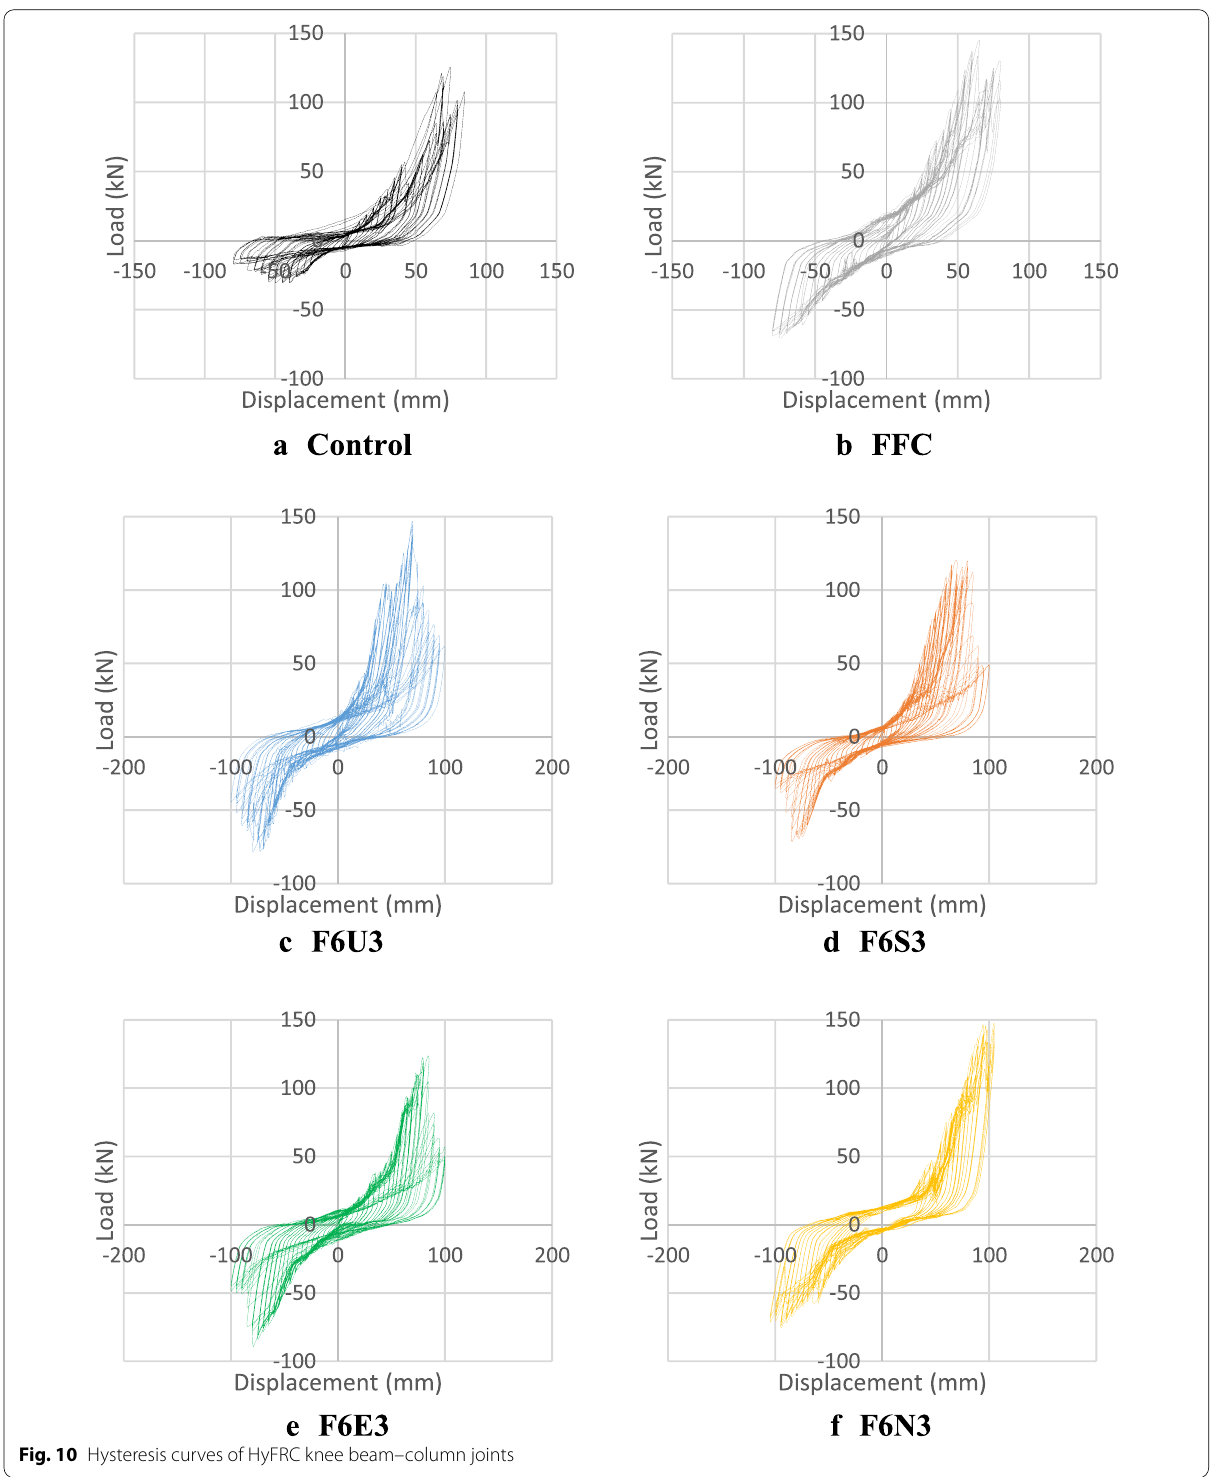
Fig. 10 Hysteresis curves of HyFRC knee beam–column